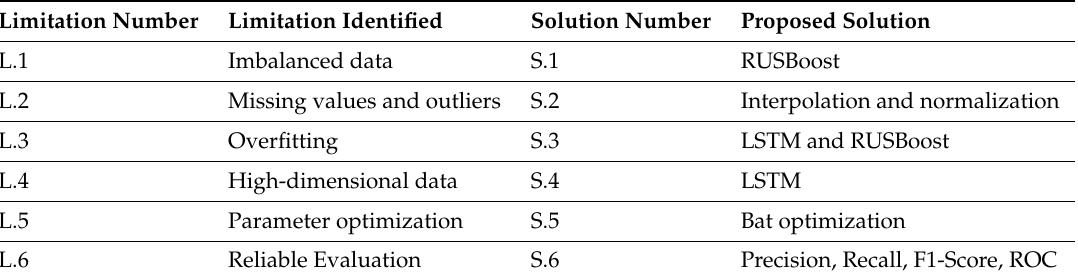
Table 1. Mapping of problems addressed and proposed solution. RUSBoost: bat-based random under-sampling boosting; LSTM: long short term memory; ROC: receiver operating